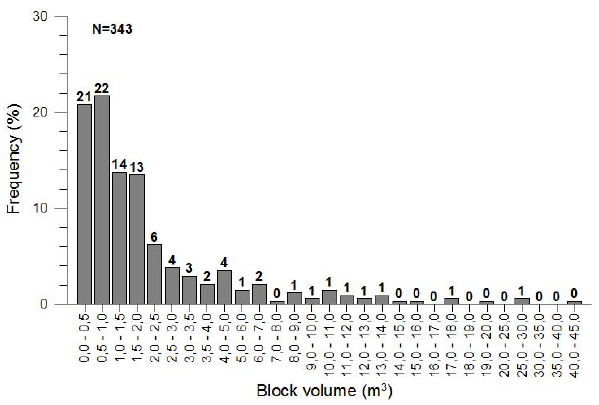
Fig. 6. Frequency chart of volume of potentially unstable rock blocks on the